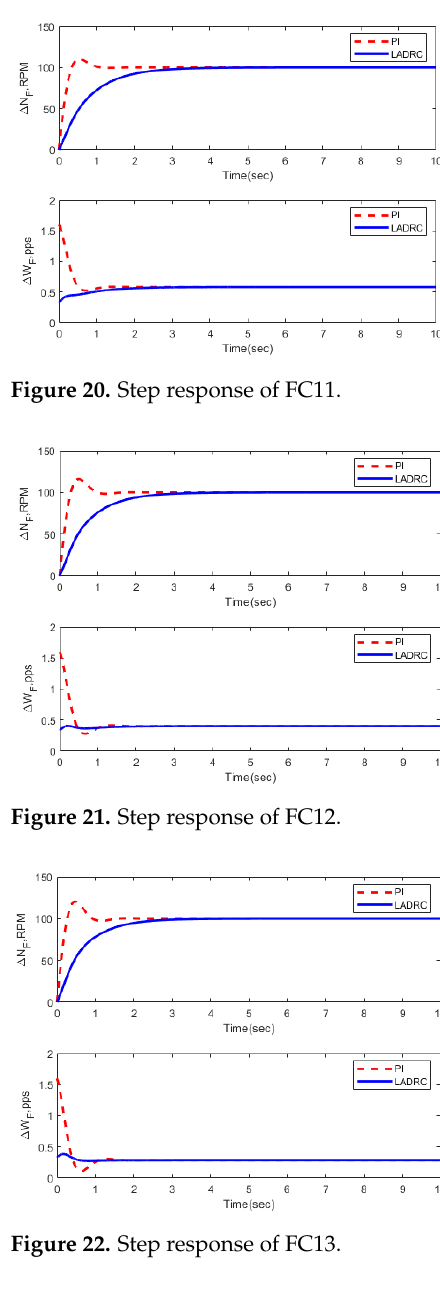
Figure 23. Step response of FC14.